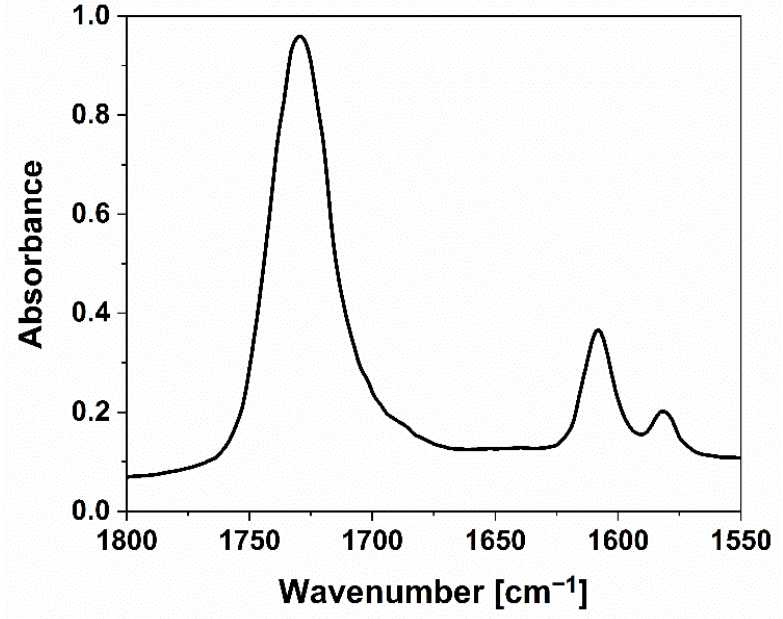
Figure 2. Typical FTIR-ATR spectrum of a UV-LED cured film containing 50 wt.% of phosphate glass powder (16 scans collected).